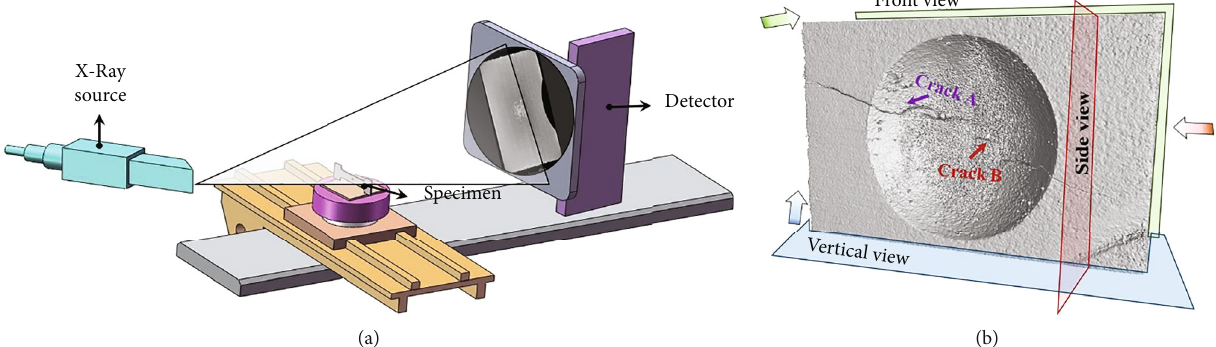
Figure 8: (a) Schematic diagram of CT scanning; (b) 3D reconstructed